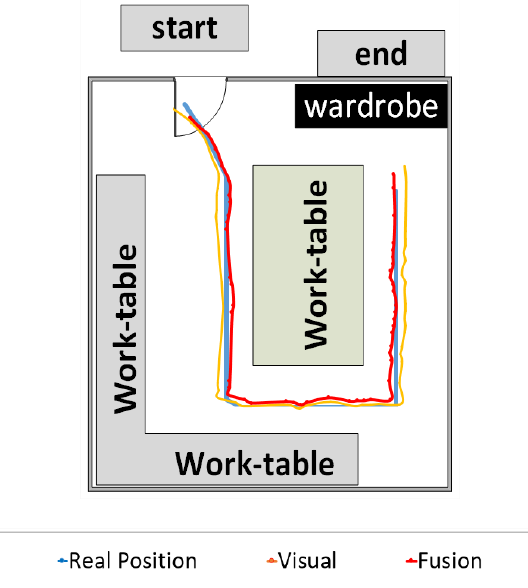
Figure 11. The result of target navigation in the lab.